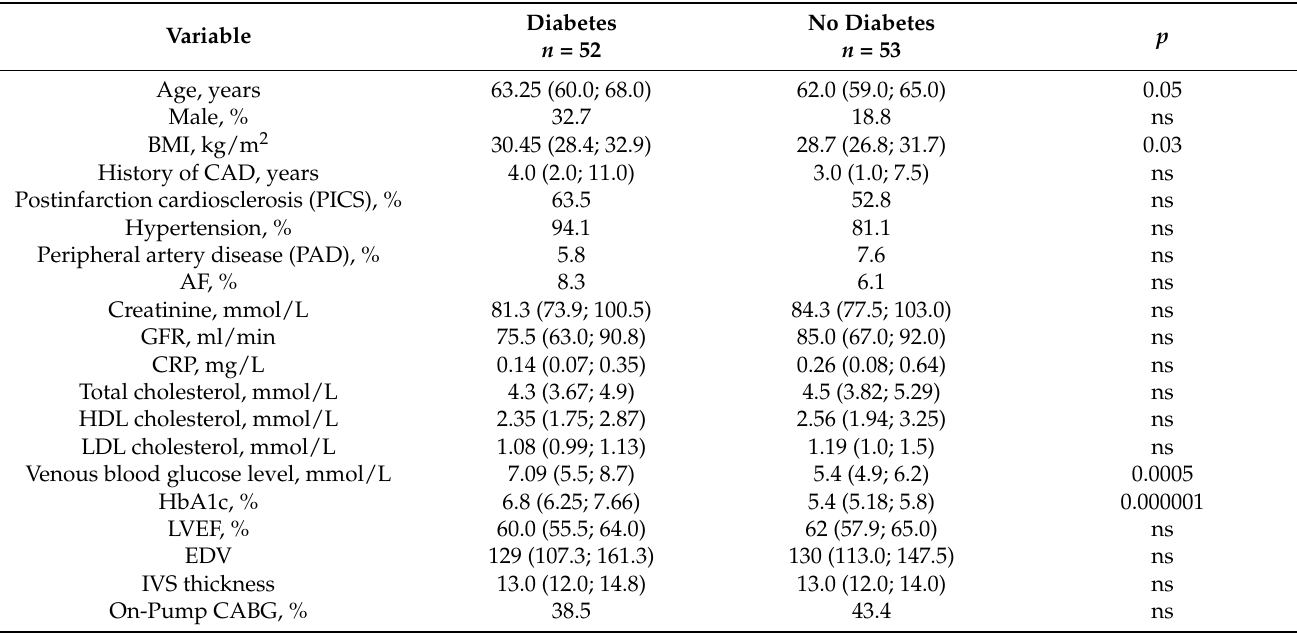
Table 1. Baseline characteristics of study